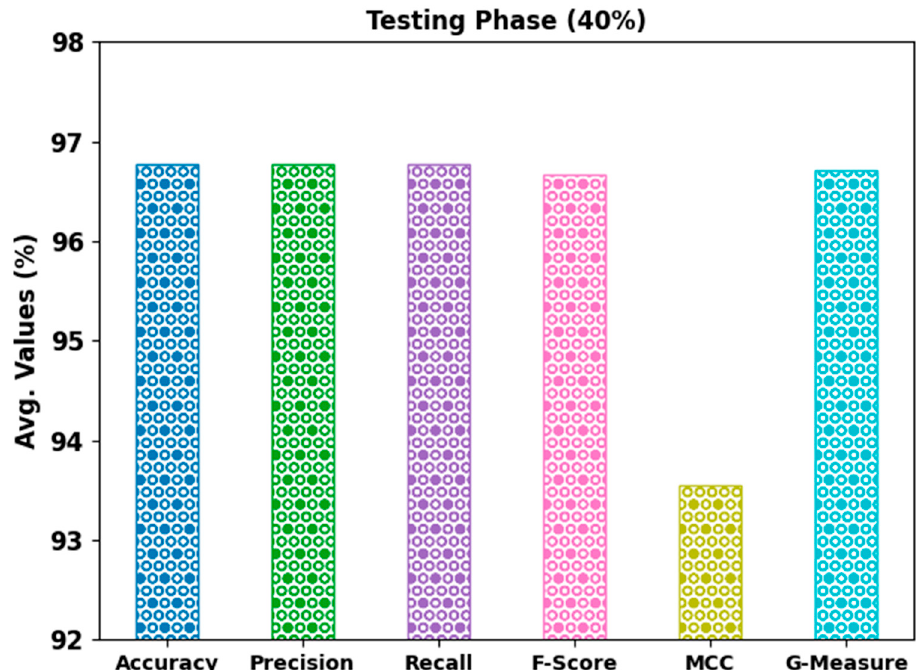
Figure 5. Average analysis of AHBATL-MNC approach under 40% of TS database. In Table 3, the overall mitosis classification outcome of the AHBATL-MNC algorithm under 70% of the TR and 30% of the TS databases is given. Figure 6 demonstrates the detailed classifier outcome of the AHBATL-MNC method on 70% of the TR database. The outcomes represent that the AHBATL-MNC system properly classified the mitosis and nonmitosis class images. It is clear that the AHBATL-MNC methodology obtained aver- age 𝑎𝑐𝑐𝑢 (cid:3029)(cid:3028)(cid:3039) of 92%, 𝑝𝑟𝑒𝑐 (cid:3041) of 93.65%, 𝑟𝑒𝑐𝑎 (cid:3039) of 92%, 𝐹 (cid:3046)(cid:3030)(cid:3042)(cid:3045)(cid:3032) of 92.26%, MCC of 85.63%, and 𝐺 (cid:3040)(cid:3032)(cid:3028)(cid:3046)(cid:3048)(cid:3045)(cid:3032) of 92.54%. Table 3. Mitosis classification outcome of AHBATL-MNC approach under 60:40 of TR/TS databases. Class